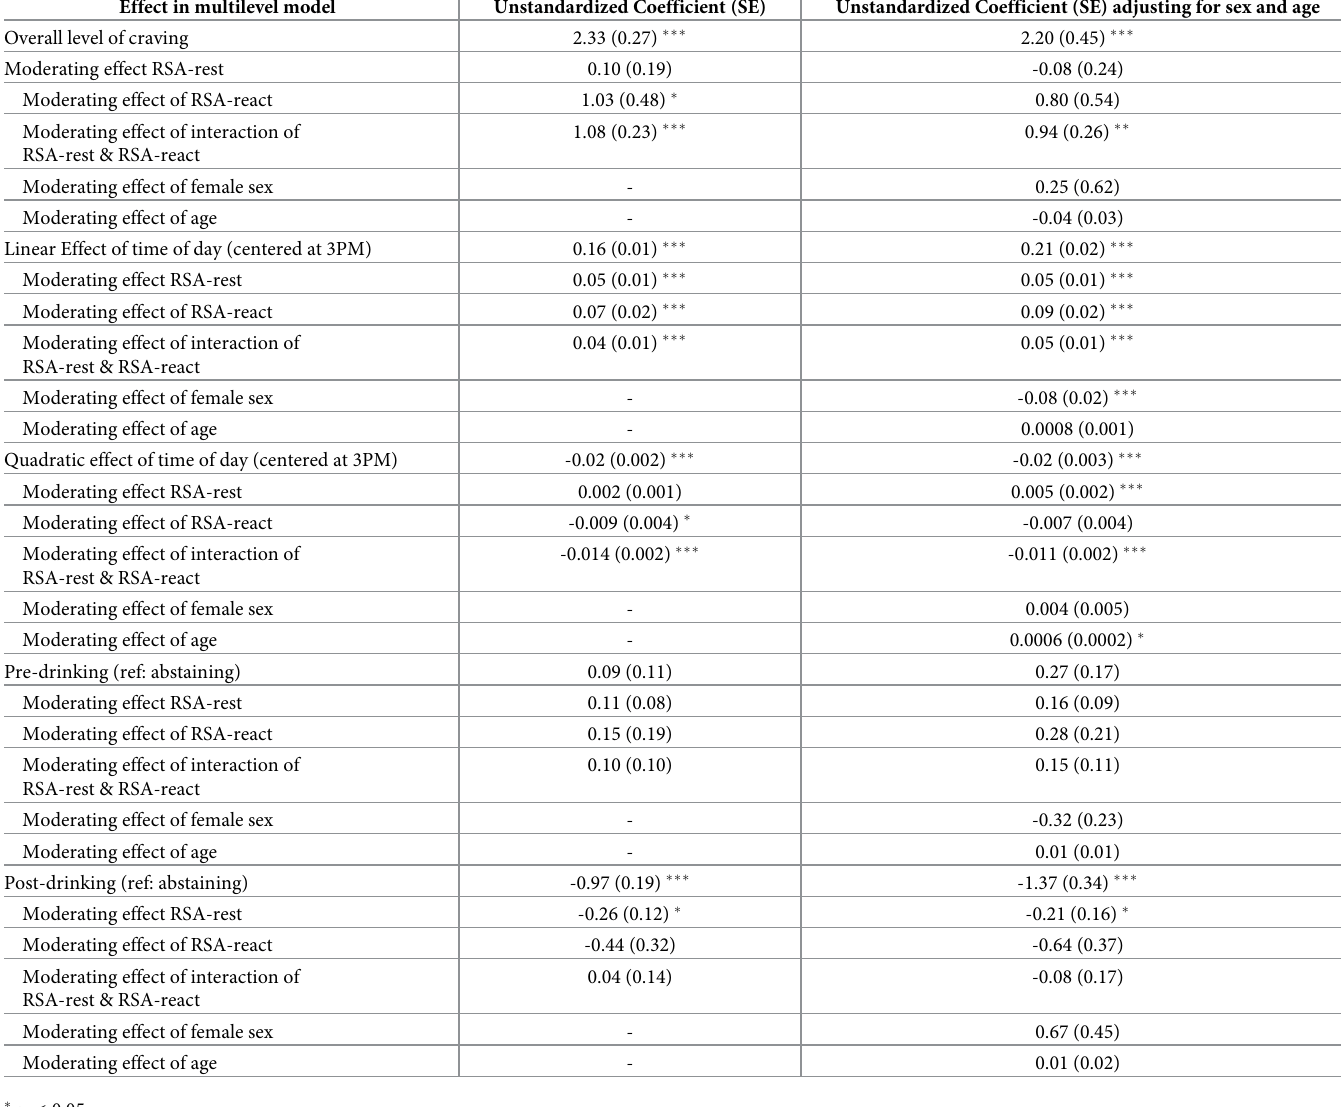
Table 3. Results of growth curve analyses examining the moderating effects of RSA-rest, RSA-react, and their interaction on the effects of time of day (linear & qua- dratic trends) and having a drinking on reported craving for alcohol. Effect in multilevel